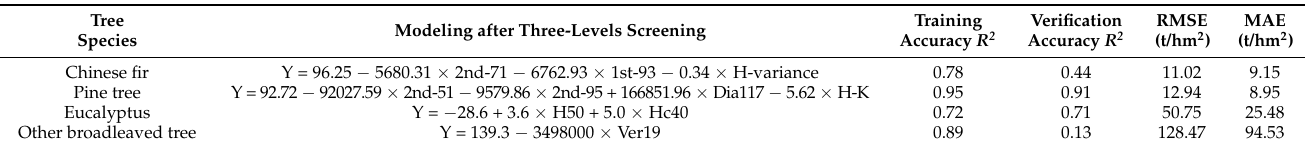
Table 8. Modeling accuracy of feature fusion. Tree